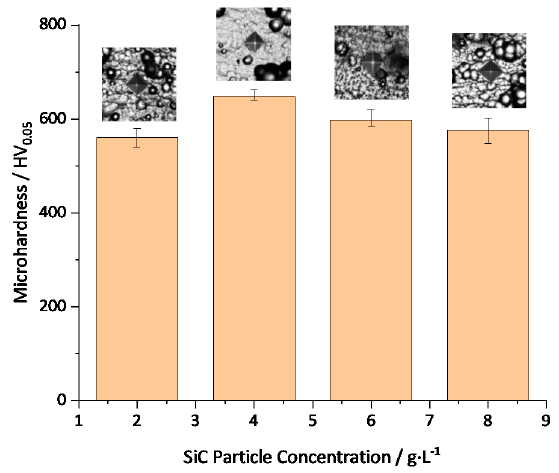
Figure 8. Effect of SiC particle concentration on microhardness of coatings.